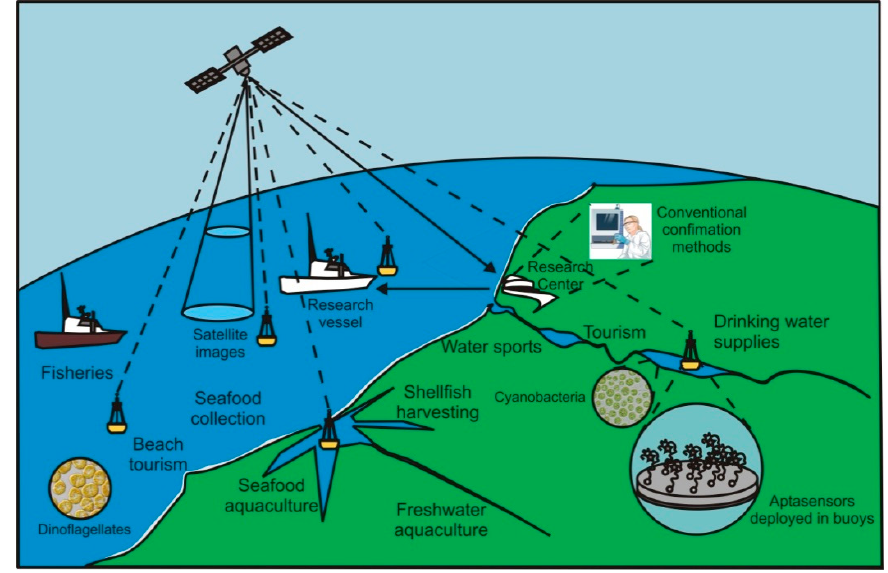
Figure 15. Integrated cyanotoxins monitoring scheme for fresh and marine waters, using buoys and a satellite. Hydrographic and oceanographic buoys emit data produced by aptasensors, and other physicochemical parameters measured by other sensors, to a satellite which forwards the information to a research center or specialized laboratory. When toxins are detected, water samples and sentinel organisms are collected by a research vessel and brought to the laboratory to follow standardized methods of analysis for each toxin. The satellite is equipped with remote sensing sensors for water masses surfaces image analysis, to produce data to correlate with those produced by ground sensors and laboratories, and feed models related to toxin-producing-microorganism blooms prediction.